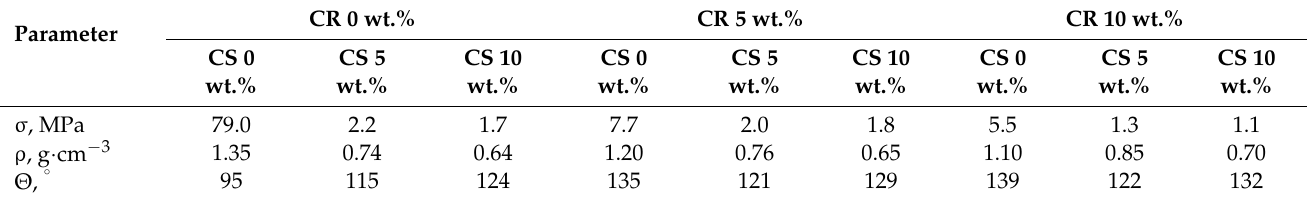
Table 4. Influence of CS on the properties of biocomposites in the shape of a